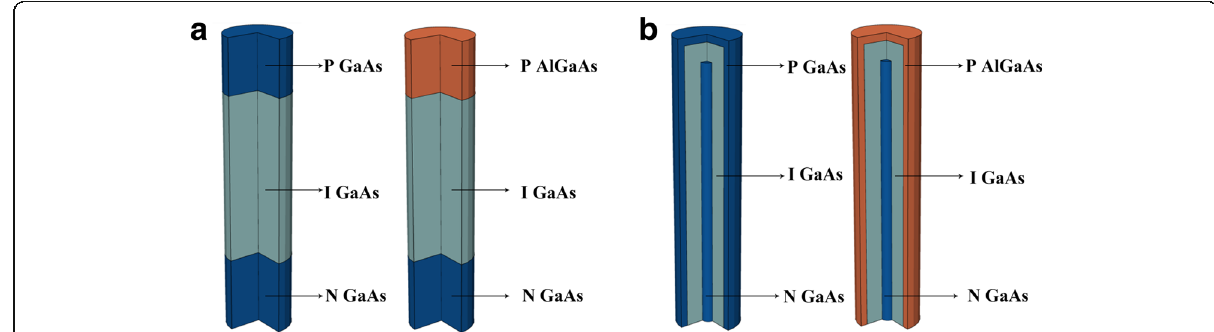
Fig. 1 a The schematic drawings of the GaAs nanowire axial pin junction solar cell and its AlGaAs/GaAs heterojunction counterpart. b The schematic drawings of the GaAs nanowire radial pin junction solar cell and its AlGaAs/GaAs heterojunction